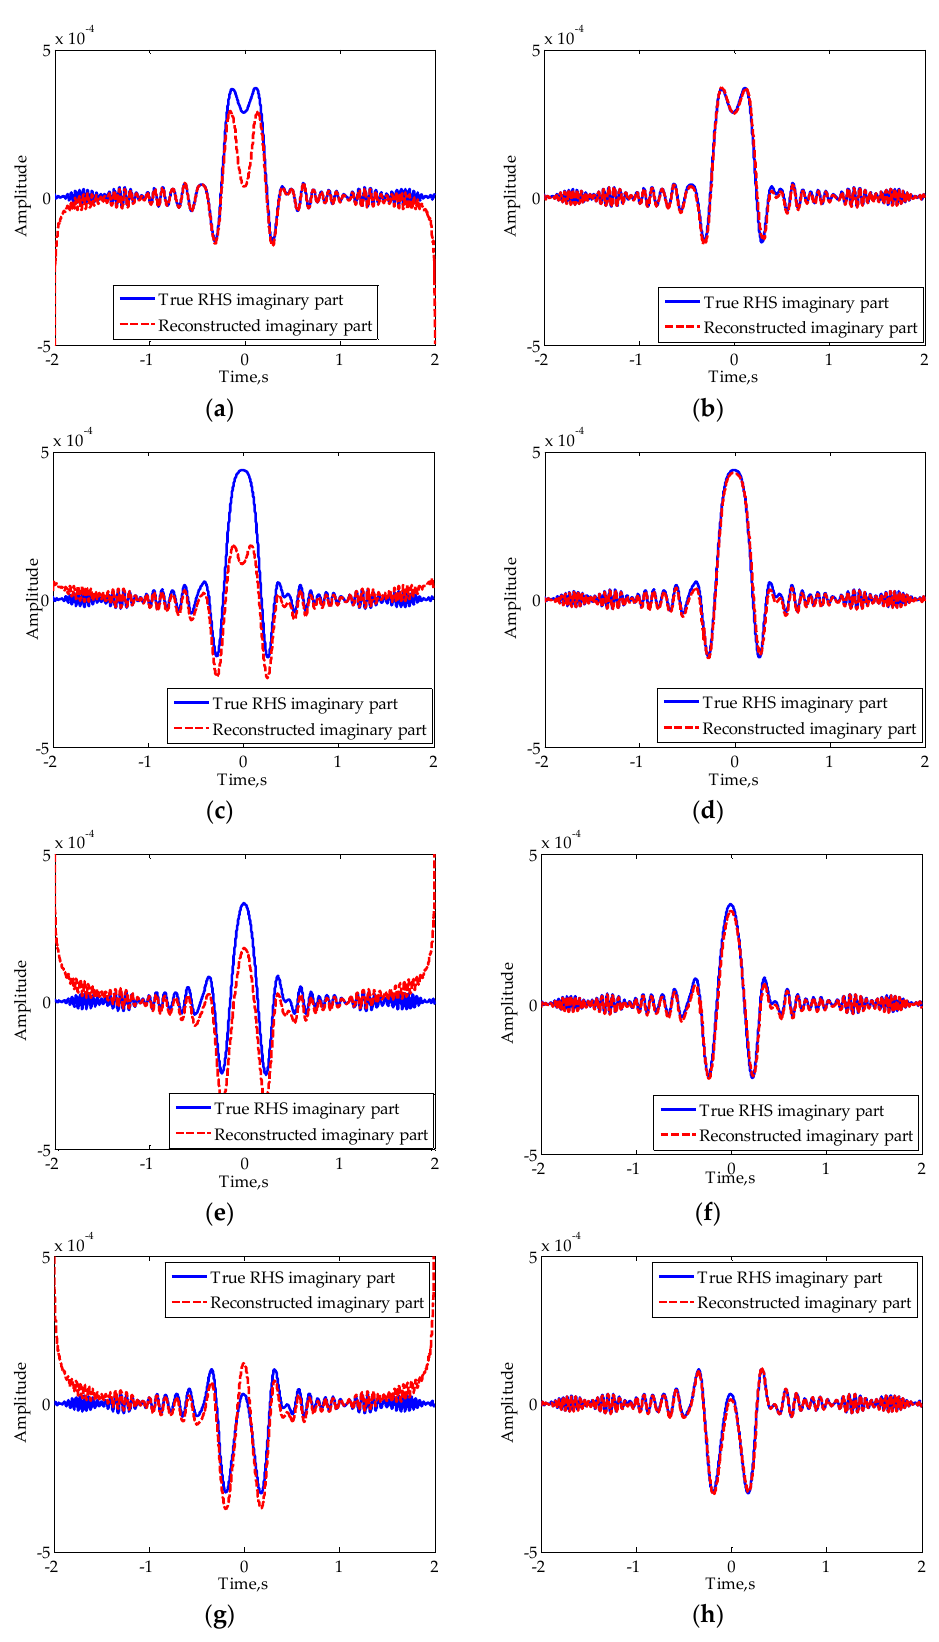
Figure 14. Reconstructed RHSs of vehicle model. In ( a , c , e , g ) the old method was used, while in ( b , d , f , h ) the new method was used. The baseline lengths are: ( a , b ) 400 m; ( c , d ) 400.0375 m; ( e , f ) 400.075 m; ( g , h ) 400.15 m.